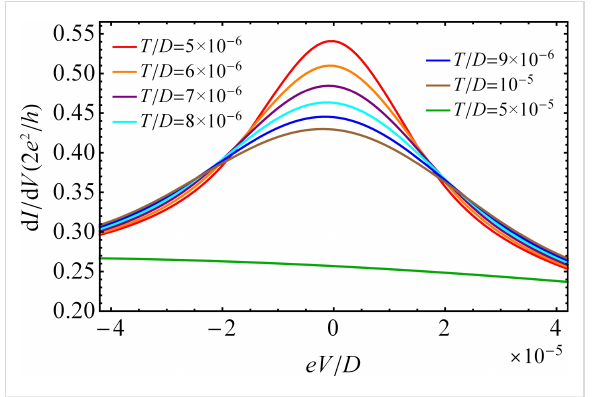
Figure 11: Differential conductance d I /d V as a function of the bias voltage eV with μ R / D = − 9.5 × 10 − 3 for different temperatures and finite U at zero magnetic field. The remaining parameters are the same as those in Figure